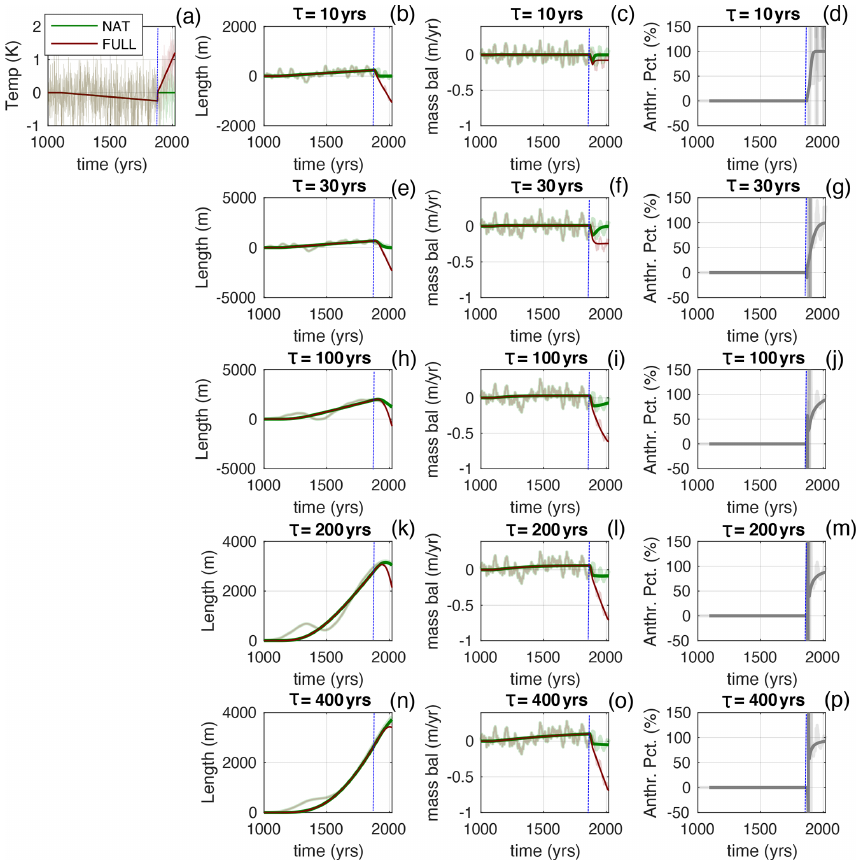
Figure 4. Same as Fig. 2 but with an abrupt end to the millennial-scale cooling at the same time as the onset of the anthropogenic